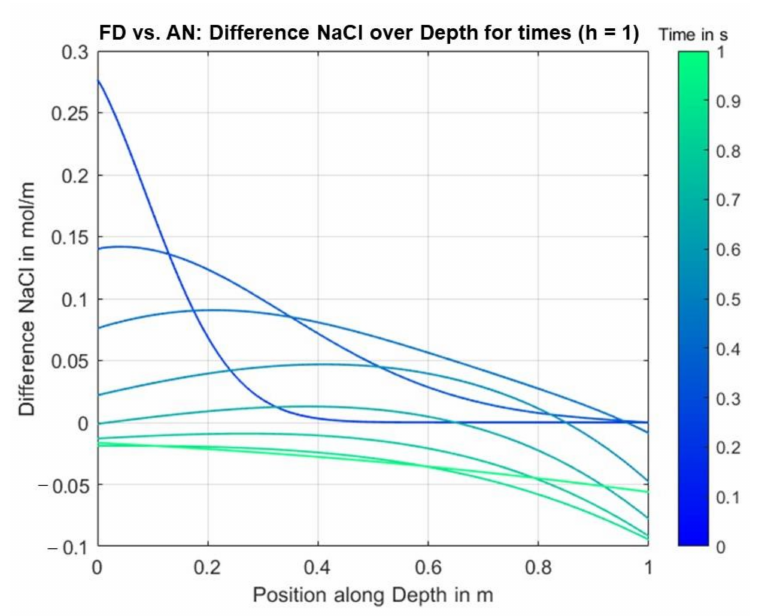
Figure 17. Differences between concentrations from analytical and finite differences